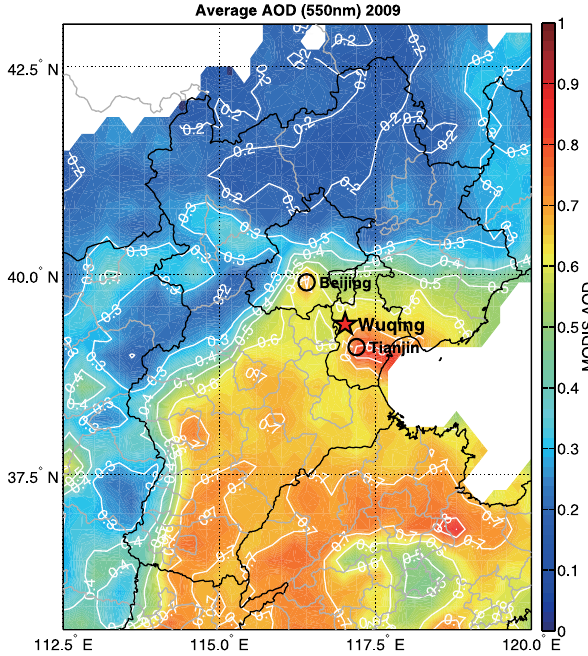
Figure 1. MODIS AOD distribution and the location of the mea- surement site (red star) and regional mega cities